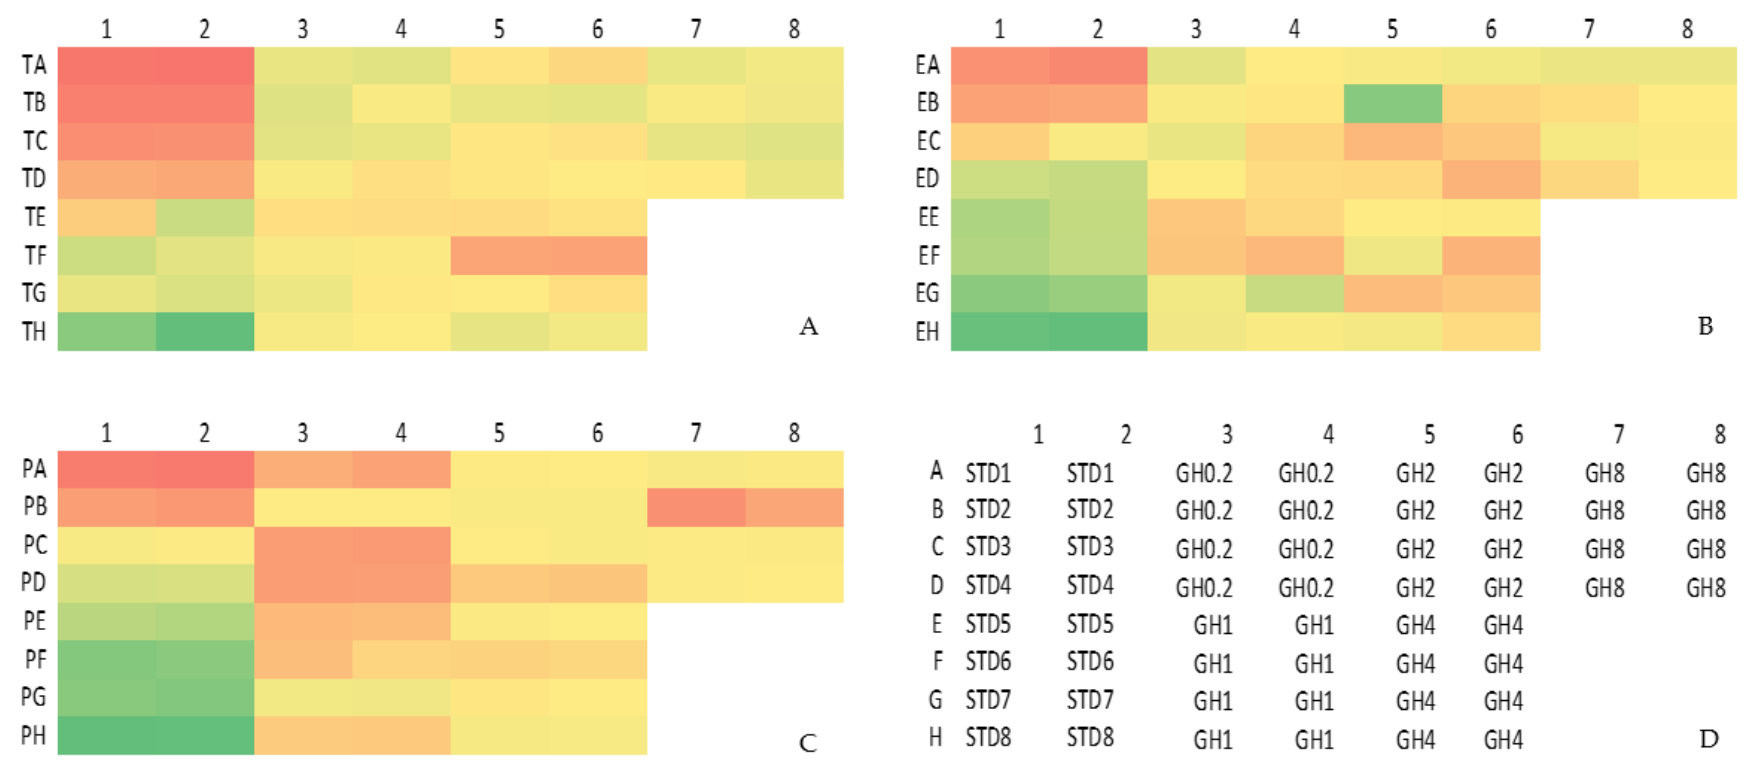
Figure 6. Heatmap of the measured serum hormone levels ( A ) T = testosterone, ng/mL; ( B ) E = estradiol, pg/mL; ( C ) P = progesterone, ng/mL. ( D ) Plate layout for competitive ELISA hormone assay. The red regions denote the highest concentrations whereas the green regions denote the lowest concentrations of each hormone. STD = standard. Testosterone STD1–STD8: 20, 10, 5, 2.5. 1.25, 0.625, 0.313, 0 ng/mL. Estradiol STD1–STD8: 100, 50, 25, 12.5, 6.25, 3.13, 1.56, 0 pg/mL. Progesterone STD1–STD8: 20, 10, 5, 2.5. 1.25, 0.625, 0.313, 0 ng/mL. GH0.2 (0.2 g GH/kg bw/day); GH1 (1 g GH/kg bw/day); GH2 (2 g GH/kg bw/day); GH8 (8 g GH/kg bw/day); bw: body